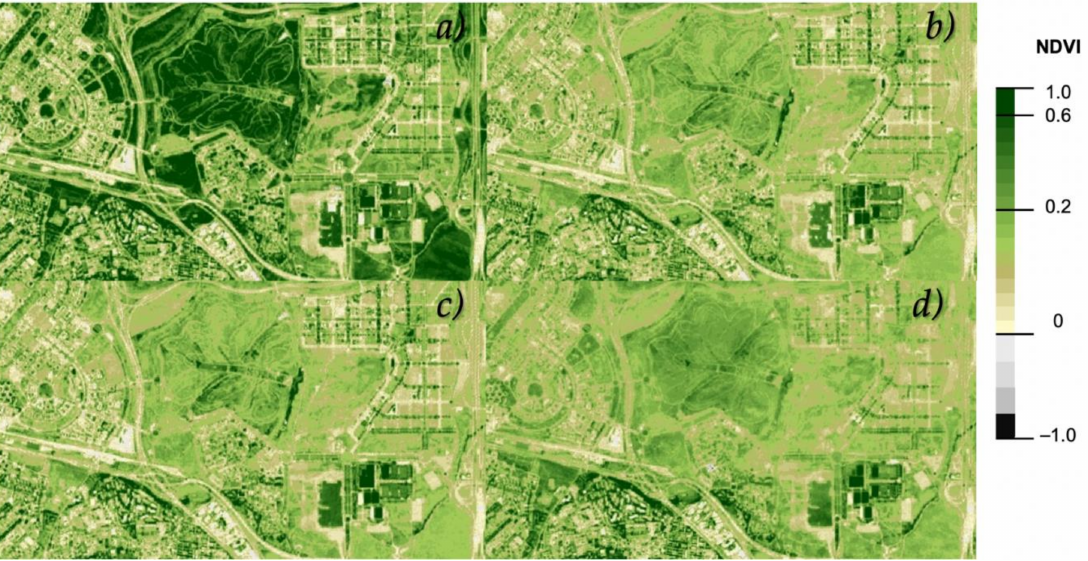
Figure 11. NDVI view of Valdebebas urbanization processed from Sentinel-2A cloud-free images: